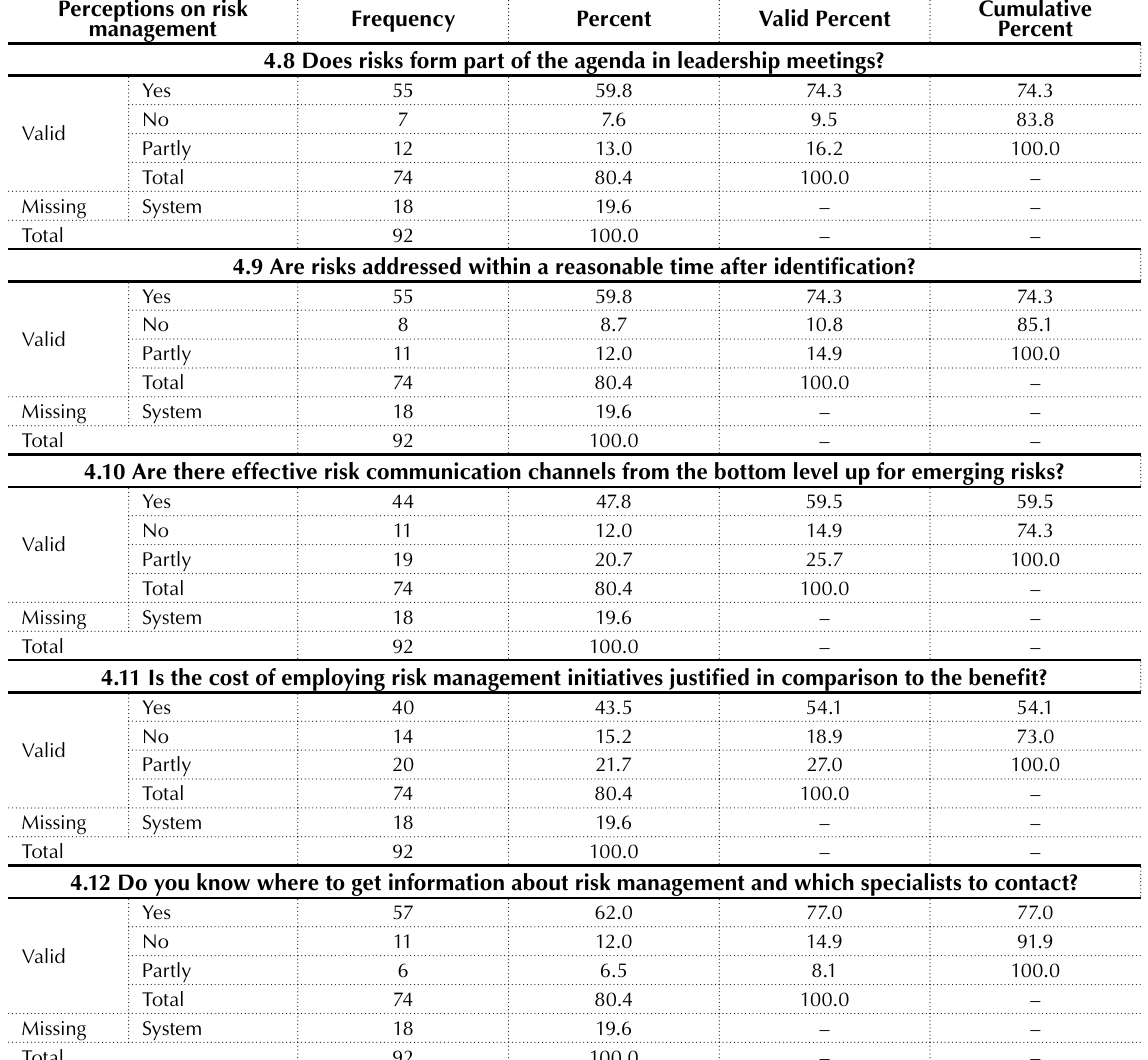
Table 4 (cont). Perceptions on risk management Perceptions on risk management